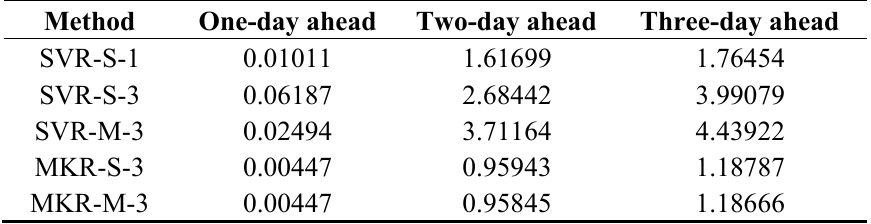
Table 4. Standard deviation of RMSE/mean for Brent Crude oil price prediction (total 14